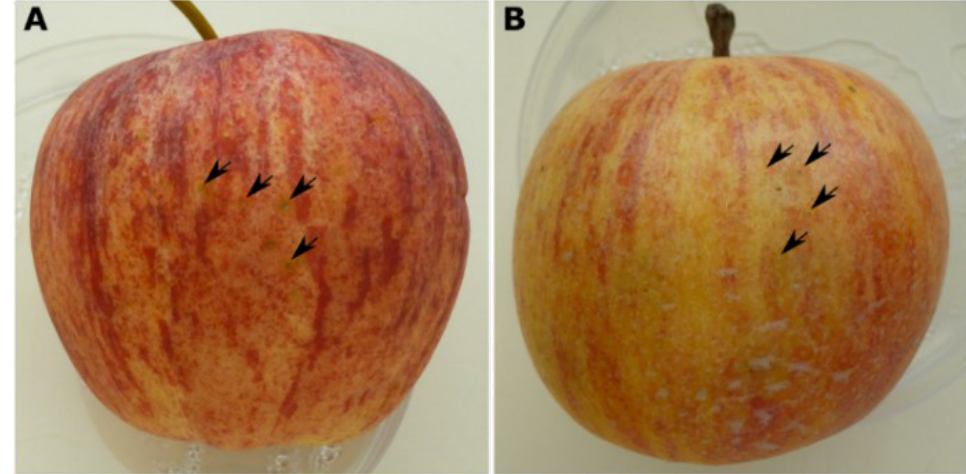
Figure 5. Representative images from water control ( A ) and B14-1 ( B ) treated cv. Gala fruit after four weeks of incubation at 22 °C. Needle wounds are highlighted with arrows.